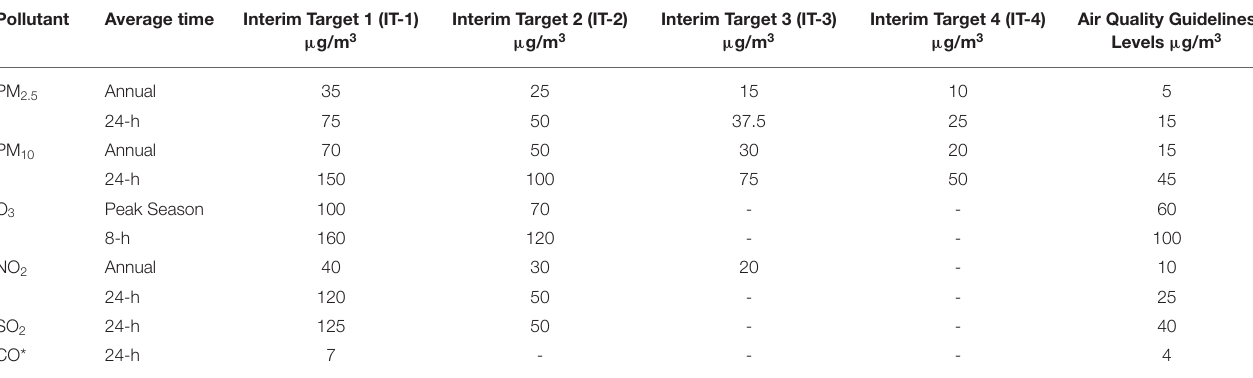
TABLE 7 | Summary of Air Quality Guidelines (AQG) levels and interim targets recommendations by WHO (36).